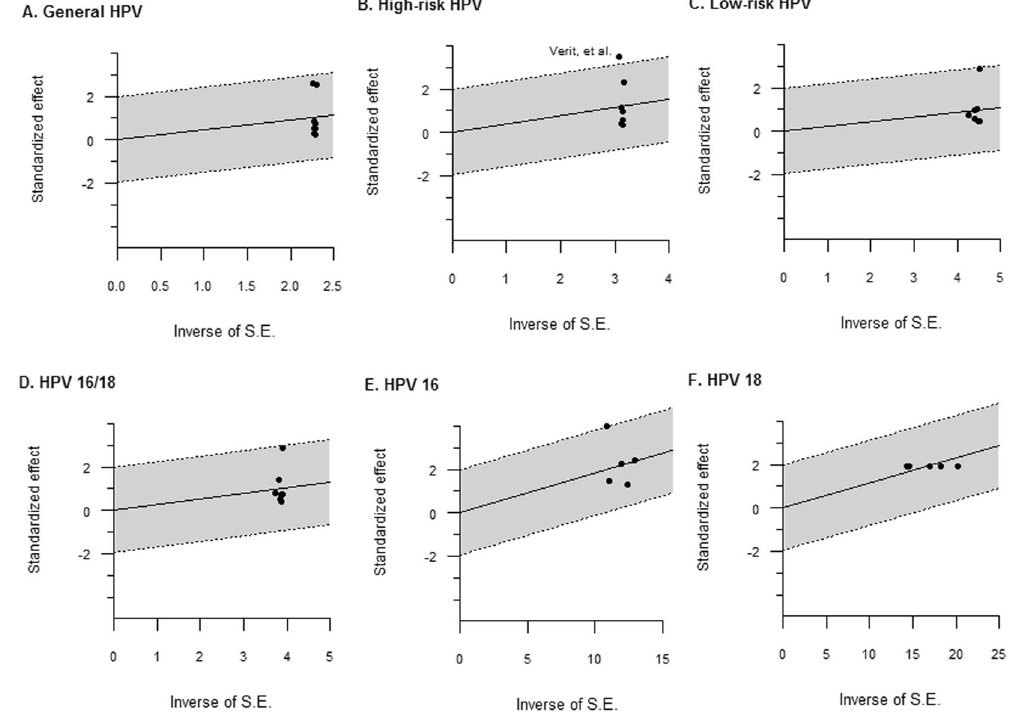
Figure 4. Galbraith plot to spot outliers for estimated meta-prevalence of HPV.